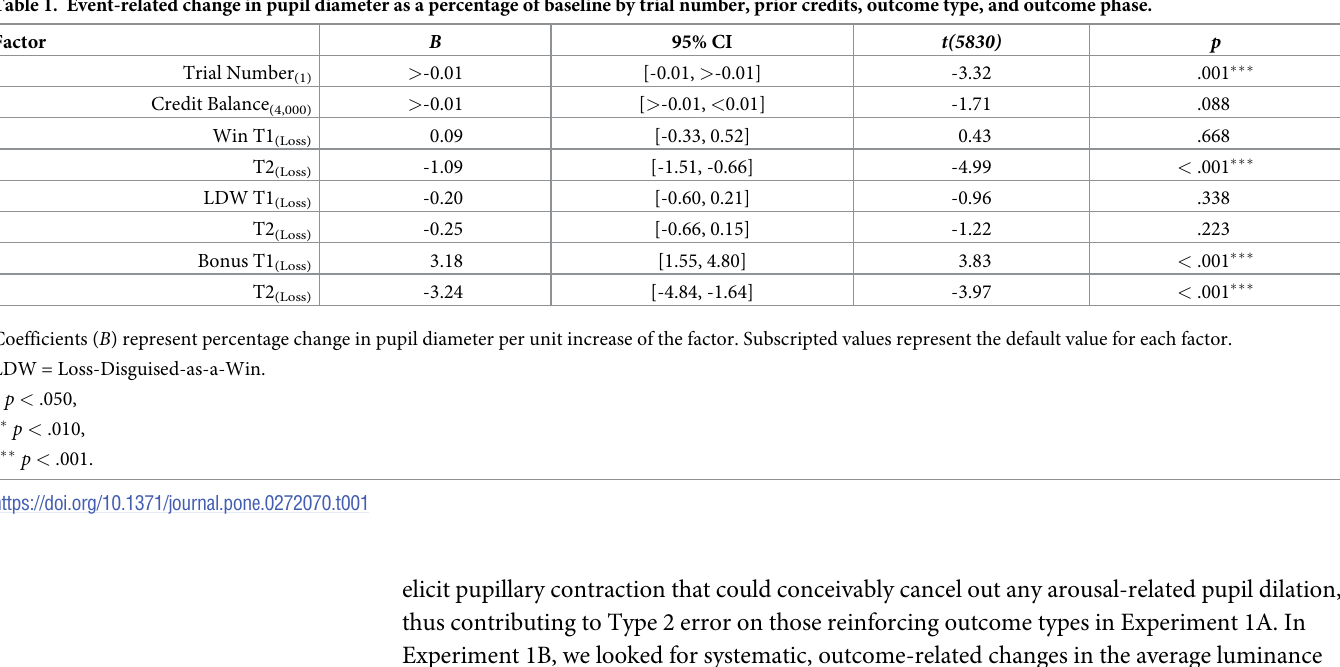
Table 1. Event-related change in pupil diameter as a percentage of baseline by trial number, prior credits, outcome type, and outcome phase. Factor